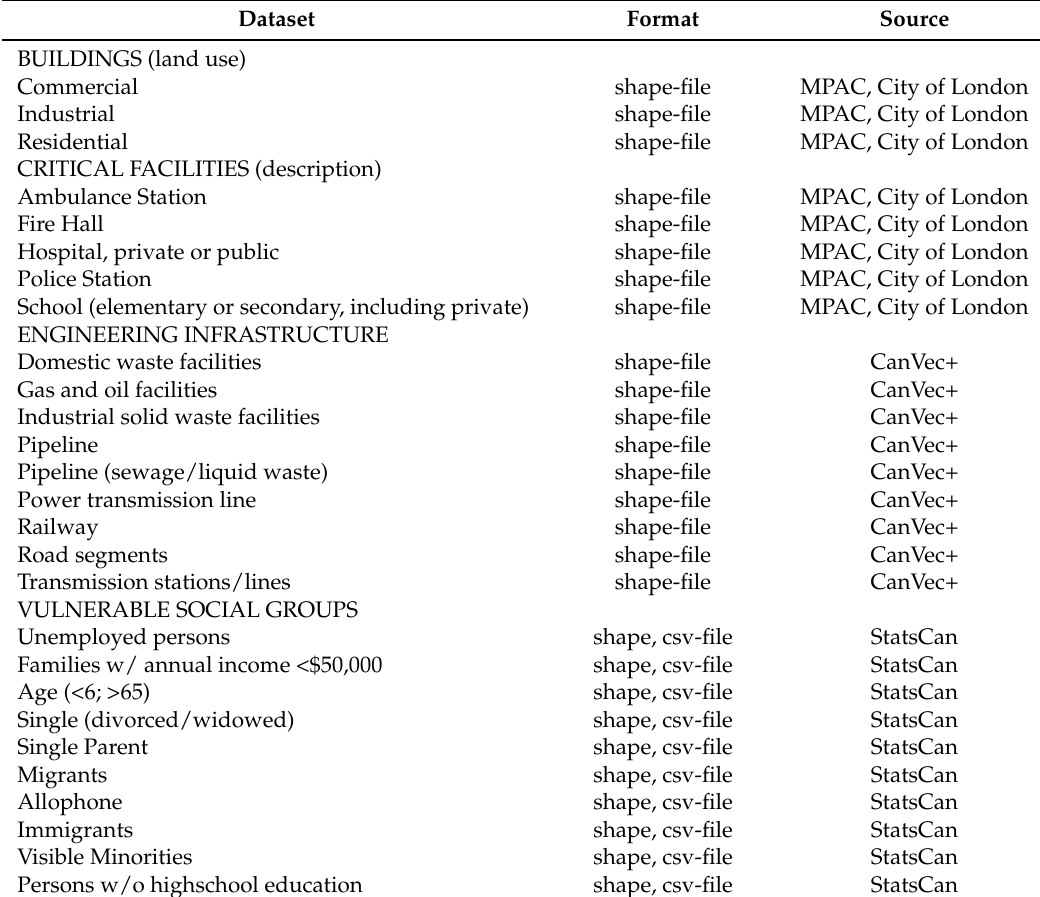
Table 1. Summary of data used in the development of